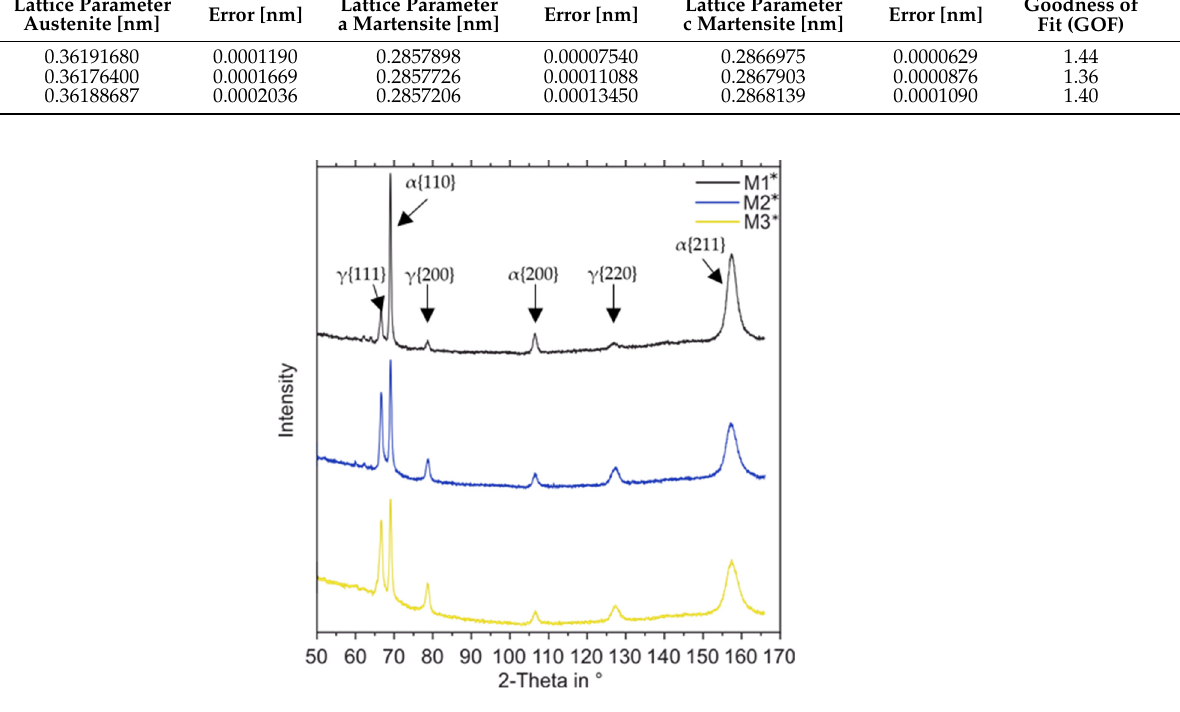
Table 7. Results of the micro hardness